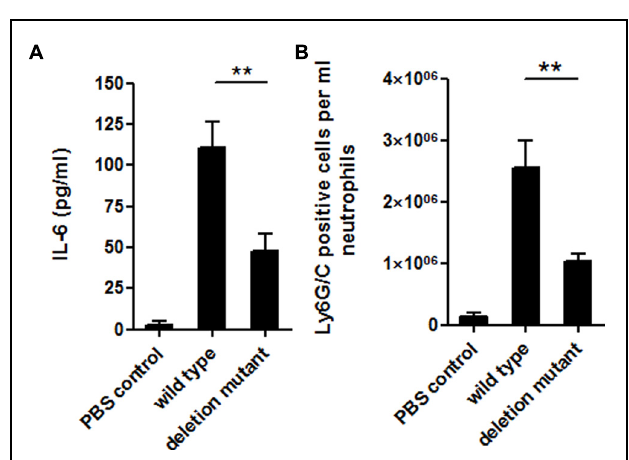
FIGURE 7 | Host inflammatory response. Levels of IL-6 (A) and number of infiltrating Ly6G/C positive cells (B) in the peritoneal cavity of BALB/c mice after intraperitoneal infection with E. faecalis OG1RF wild-type and OG1RF (cid:2) mafR mutant strain. PBS treated animals served as negative controls. Each bar represents the mean ± SD of three independent experiments, ∗∗ p <